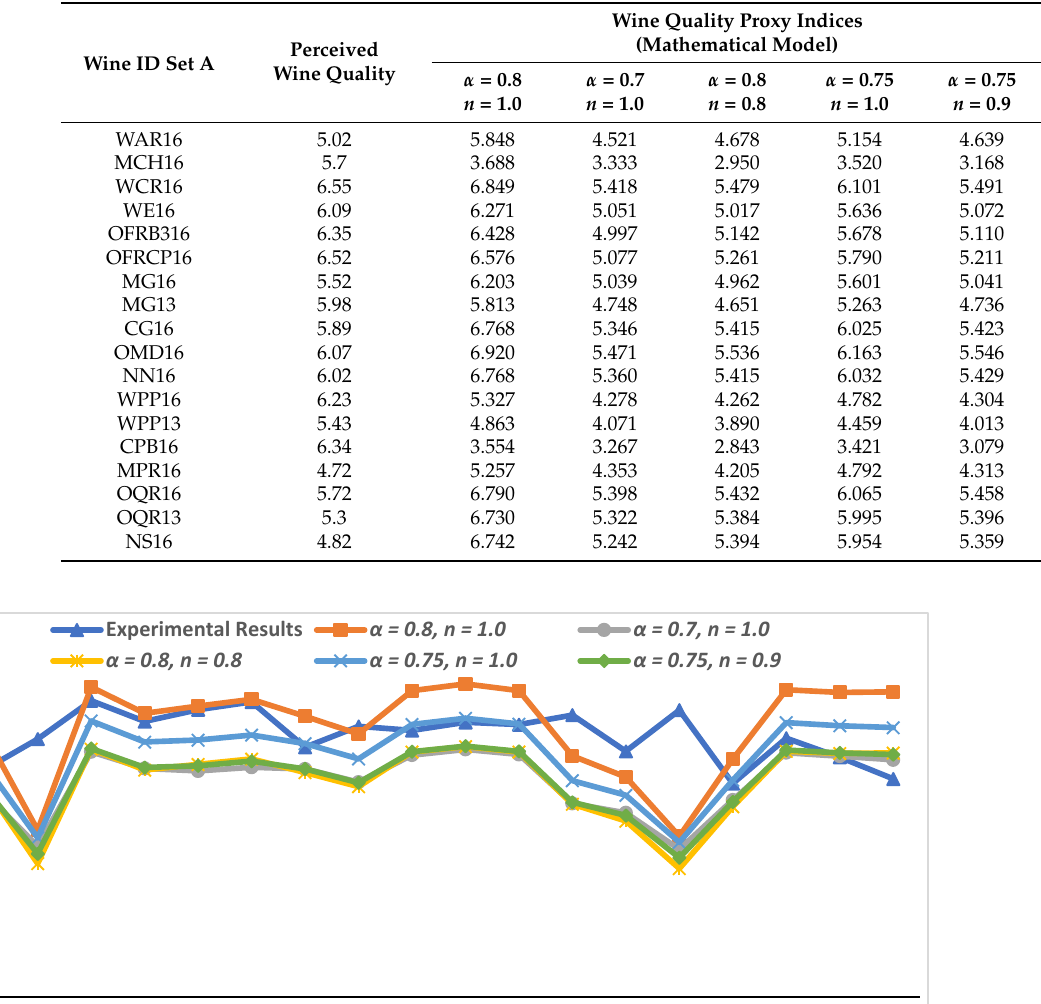
Table 6. Quality proxy indices based on a mathematical model.